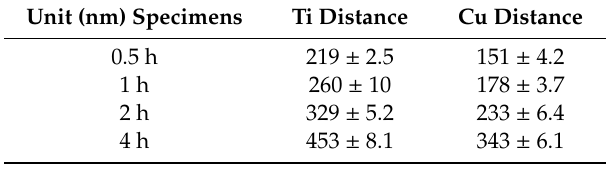
Table 1. Di ff usion distance of each component from the interface layer. Table 1. Diffusion distance of each component from the interface layer.